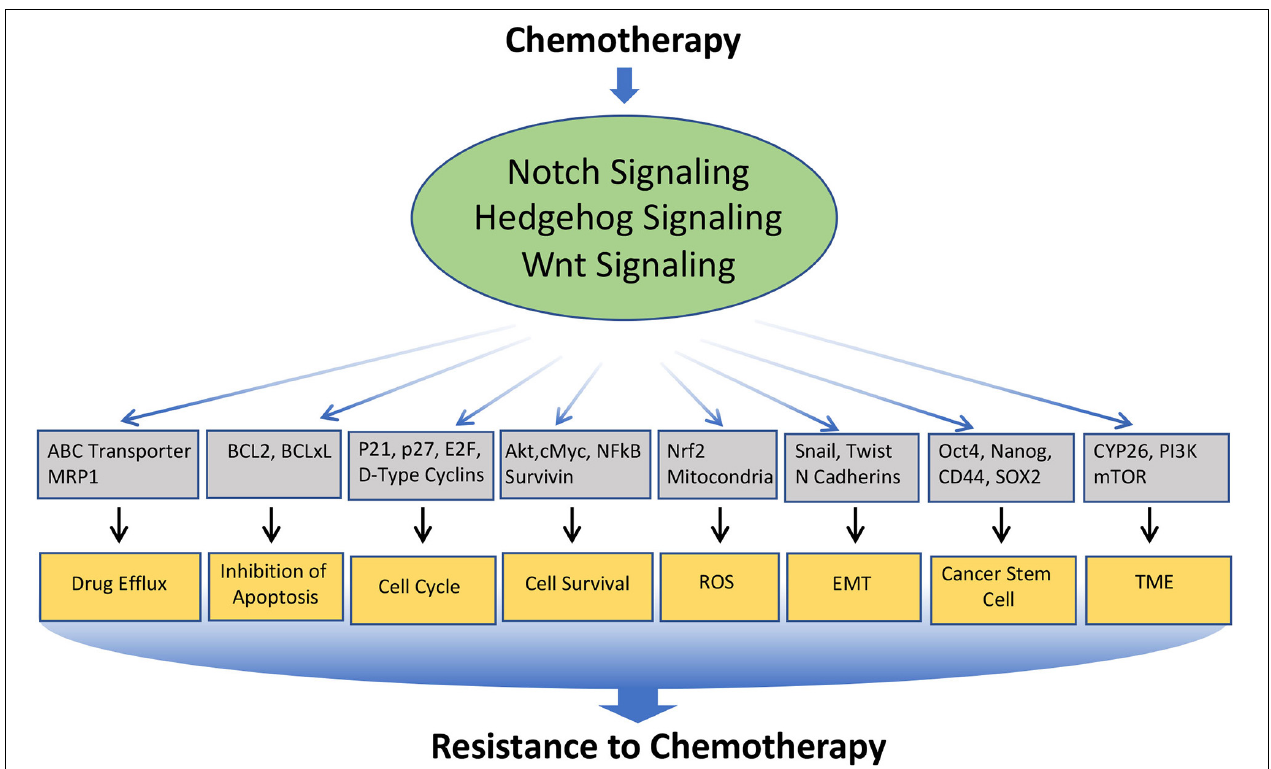
FIGURE 3 | Involvement of Notch, Hedgehog, and Wnt signaling pathways in the resistance of cancer cells to chemotherapeutics drugs: Various anticancer drugs often upregulate Notch, Hedgehog, and Wnt signaling, which in turn regulates the key molecules involved in cellular processes such as Drug efflux, Inhibition to apoptosis, cell survival, cell-cycle, ROS, EMT, CSC, DNA damage response, TME, immune cell functions, etc. that leads to the acquisition of resistance to the chemotherapeutics